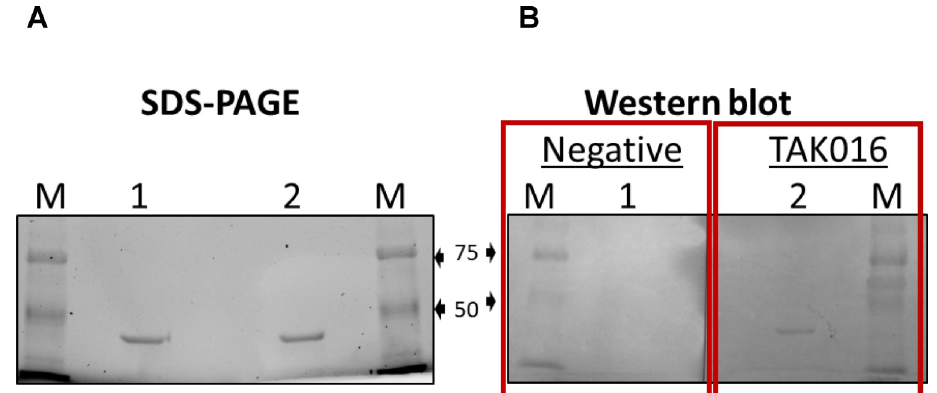
Fig 4. Polyacrylamide gel electrophoresis ( SDS-PAGE) of B . miaymotoi recombinant GlpQ protein (A) and Western blot analysis (B) of Tak patient (TAK016) positive for B . miyamotoi by the in-house ELISA assay (titer 400).